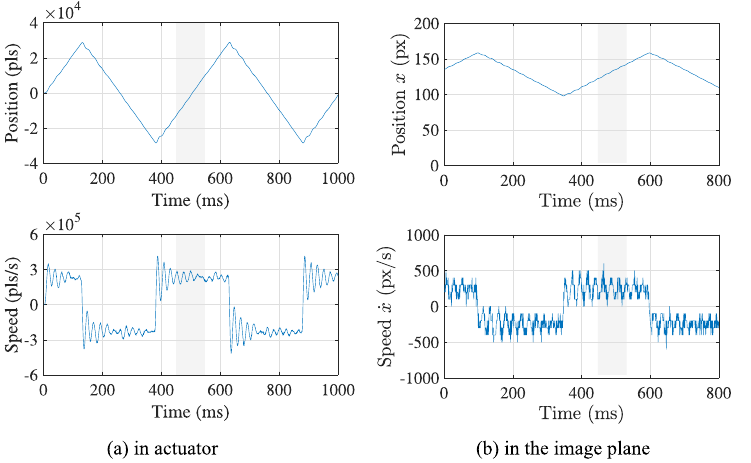
Figure 4. Example of a triangle wave achievable in the practical case. The retrieved trajectory is apt to be deteriorated by the practical limitation of the actuator control. The outward peak positions generated by an actual actuator are shifted by the noisy measurement result due to the inertia of the system and friction force, etc., which hinders detecting the true positions of the